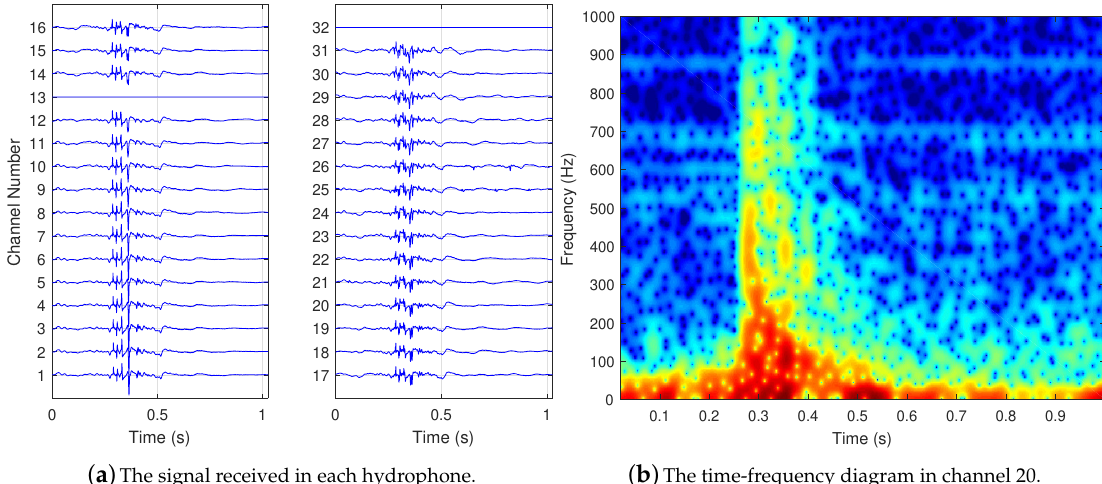
Figure 5. The illustration of air-gun signals received by VLA. ( a ) The time domain diagrams from all channels. The channel 13 and 32 failed. ( b ) The time-frequency domain diagrams in the channel